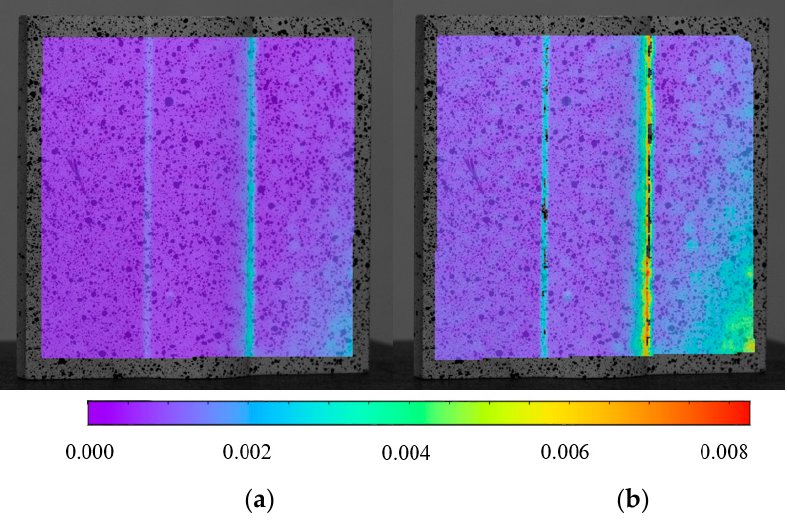
Figure 10. Contour statistical error map/mm. ( a ) contour statistical error calculated under three perspectives; ( b ) under two perspectives (green channel was not included).